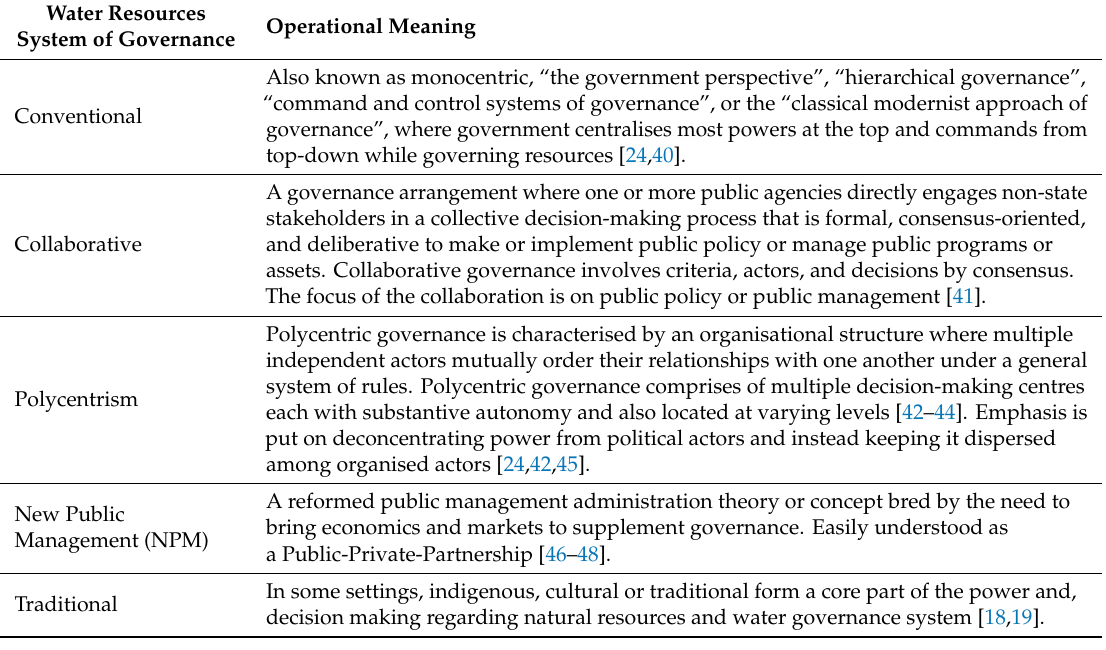
Table 1. A summary description of select resources systems of